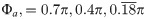
Validation of Eq (72).Left: absolute value of I1+(η). Right: relative error in log10 scale obtained from the approximate expression of I1+(η) given by Eq (72) while substituting the exact expression of V1+(η) and performing the numerical integration. Test cases are relative to different sets of parameters: Φa,=0.7π,0.4π,0.18¯π, Φb = 1.2π, φo = 0.1π. We recall that φ = Φa and φ = −Φb are the azimuthal directions of the PEC faces of the wedge and φ = φo is the azimuthal direction of the incident Ez-polarized plane wave.